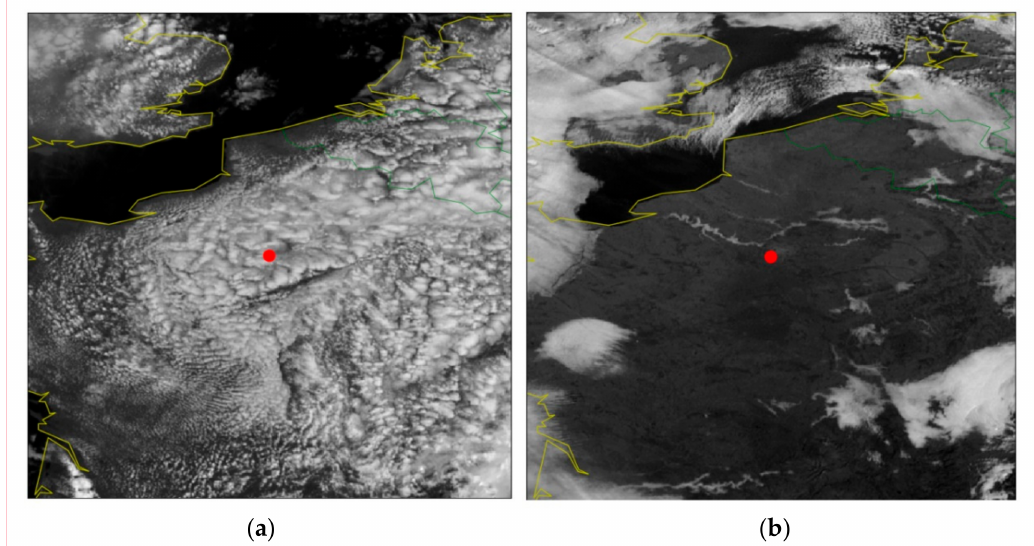
Figure 4. Examples of satellite image. ( a ) has been acquired the 13 June 2018 at 1200 UTC during the Atlantic Ridge regime. It presents a heterogeneous convective cloud field. ( b ) has been acquired the 25 December 2018 at 1200 UTC during the Scandinavian Blocking regime. A clearer and stable situation is shown. One can remark fog along the Seine river at the north-west of Palaiseau (the red spot locates